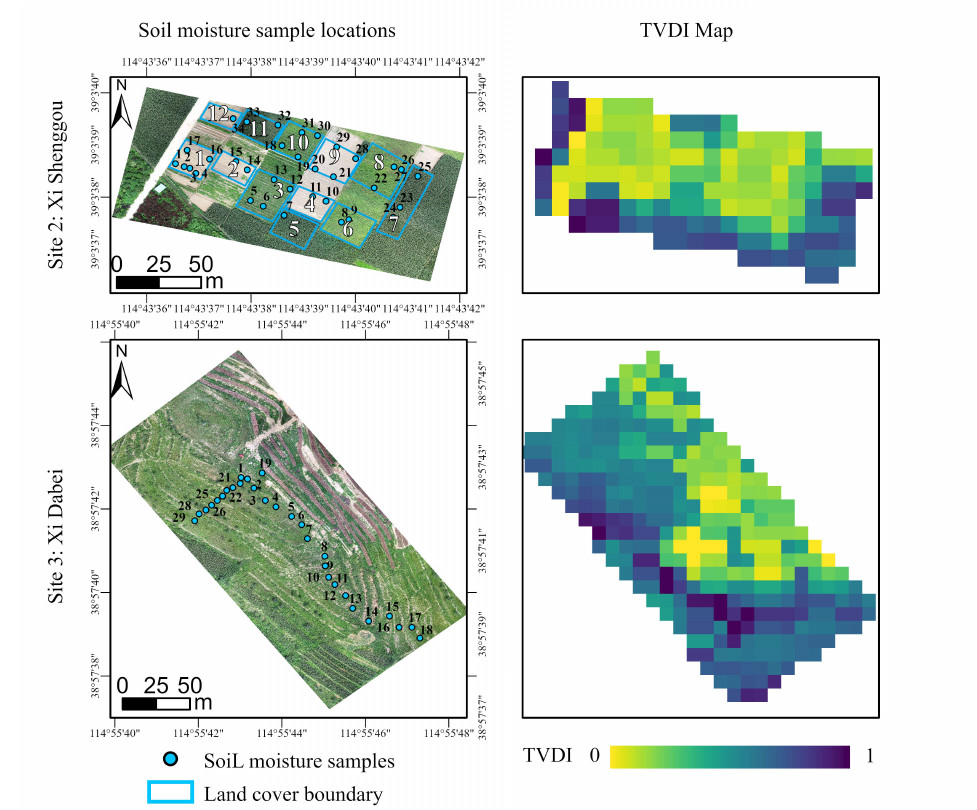
Figure 10. The distribution of soil moisture sampling points in the UAS orthophotos (first column) and the TVDI maps (second column) in two sites.